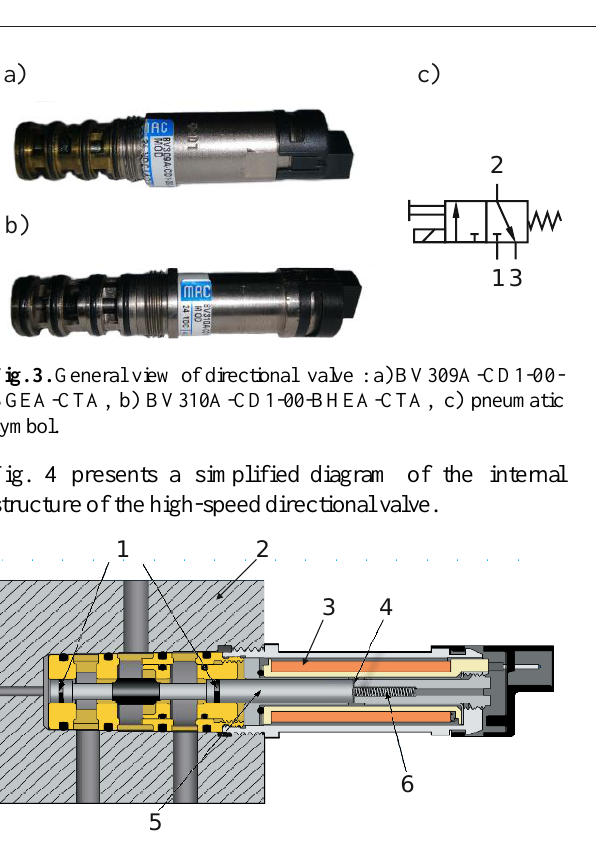
Fig. 4. Internal structure of high-speed directional valve : 1 – seals, 2 – housing, 3 – electromagnetic transducer, 4 – overstroke, 5 – poppet, 6 – return spring.